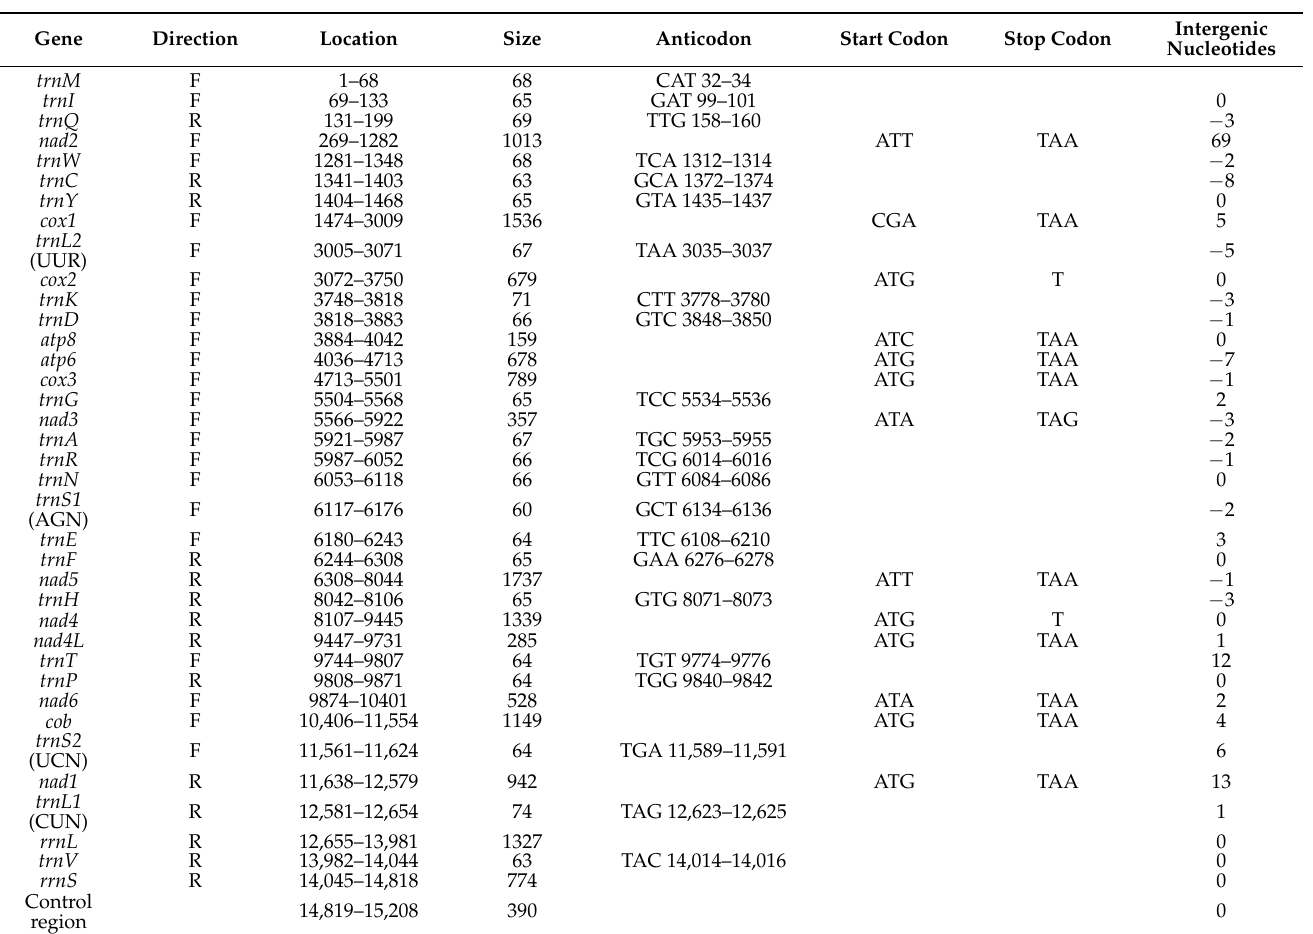
Table 2. Annotation of Hestinalis nama